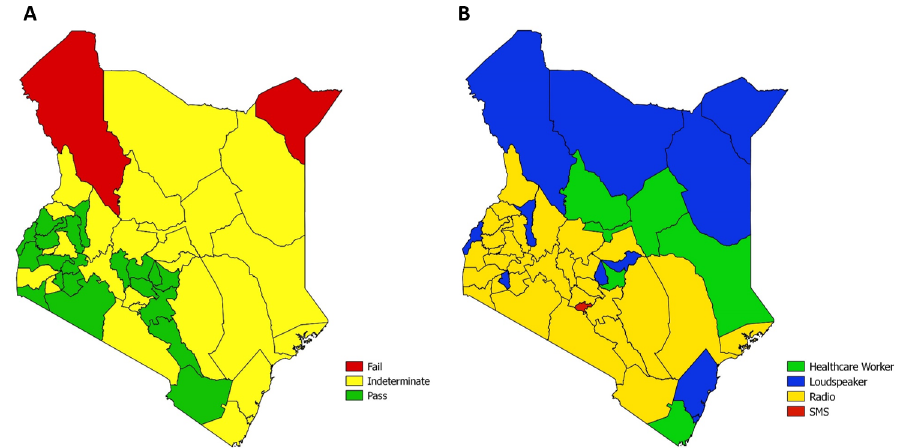
Fig 2. Map of measles-rubella (MR) campaign vaccination coverage and reported information sources by county —Kenya, 2016. (A) Using one-sided hypothesis testing against a programmatic threshold of 95%, MR campaign coverage of children aged 9 months–14 years was classified by county as either passing (likely to have coverage (cid:21) 95%), intermediate (unable to confidently classify as above or below 95% given the survey sample size), or failing (likely to have coverage < 95%). Mandera is the northeast county depicted in red, which was the site of a measles outbreak in 2016, and Turkana is the other county depicted in red in the northwest. (B) The main source of MR campaign information that was most frequently reported by caregivers is depicted by respective county of residence.